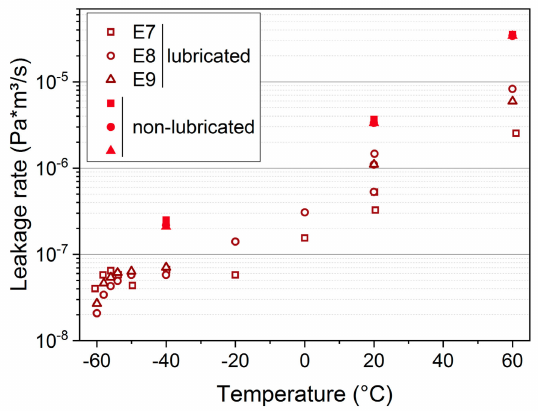
Figure 15. Leakage rates of lubricated (with silicon oil) and non-lubricated EPDM seals aged for 30 d at 150 ◦ C.